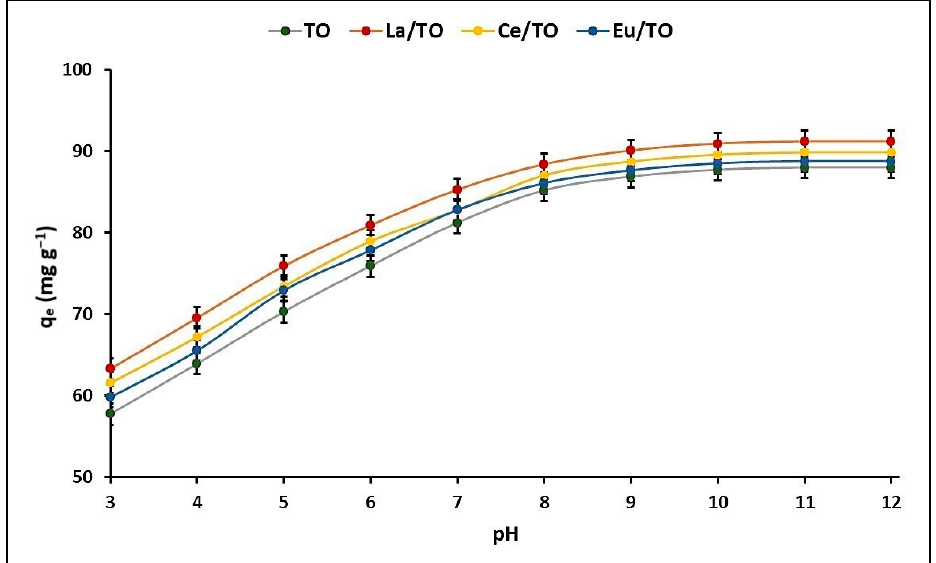
Figure 6. Solution pH effect experiment.